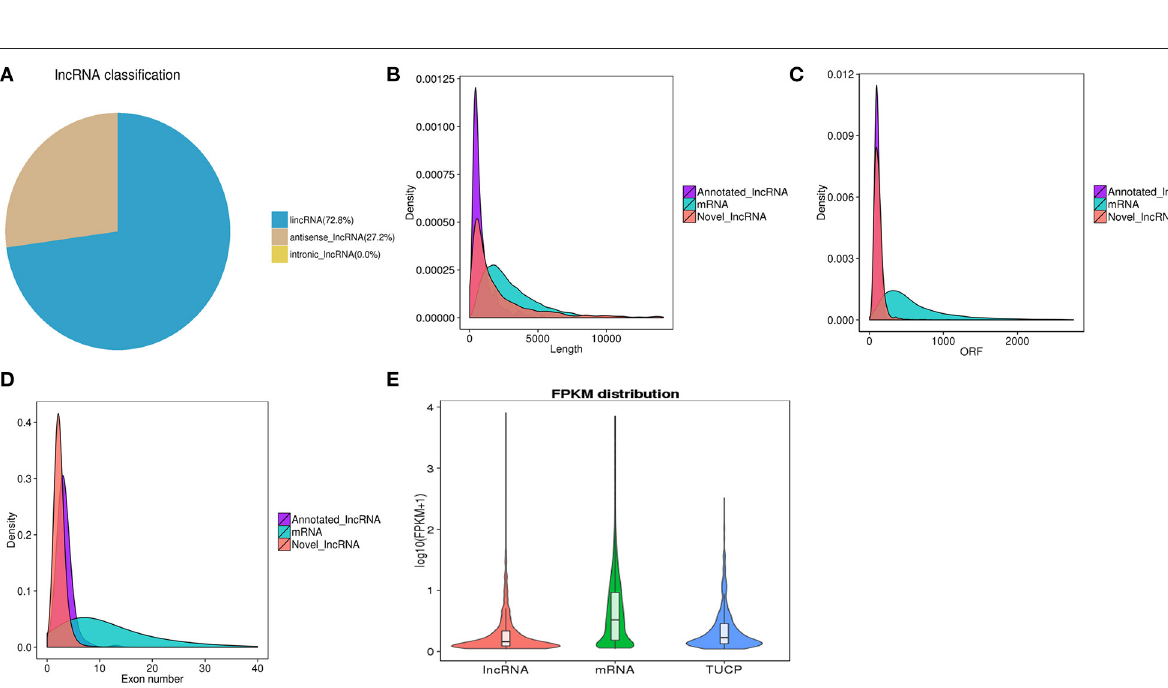
FIGURE 2 | (A) Classification of lncRNAs in three classes. (B) Comparison of transcript lengths in annotated lncRNAs, mRNAs, and novel lncRNAs. (C) Comparison of ORF lengths in annotated lncRNAs, mRNAs, and novel lncRNAs. (D) Comparison of exon numbers in annotated lncRNAs, mRNAs, and novel lncRNAs. (E) Expression levels of lncRNAs, mRNAs, and TUCP from all